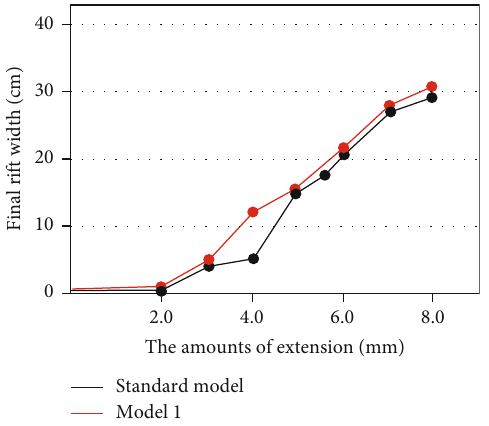
Figure 6: Final rift segment width as a function of extension, measured from the model surface views in Figures 4 and